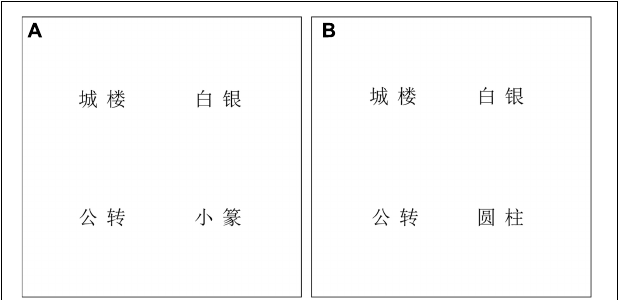
FIGURE 1 | An example of a printed-word display in Experiment 1. For the spoken target word , gong1zhuan4 , “revolution,” the printed-word display consisted of an identical target word, a phonological competitor word in the syllabic overlap condition (A) , xiao3zhuan4 , “calligraphy” or in the sub-syllabic overlap condition (B) , yuan2zhu4 , “cylinder” and two unrelated distractors , cheng2lou2 , “gate tower” and , bai2yin2 , “silver” in four corners of the